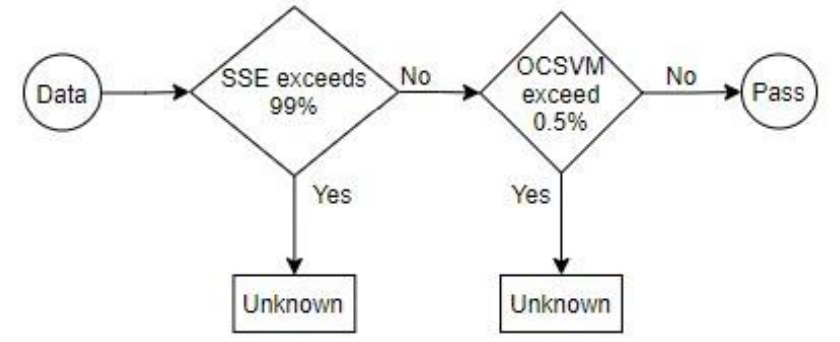
Figure 6. Unknown identification Figure 6. Unknown 2.